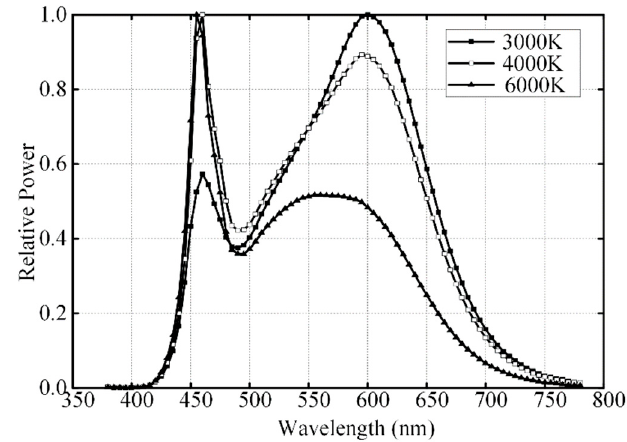
Figure 3. The relative power of three light sources.